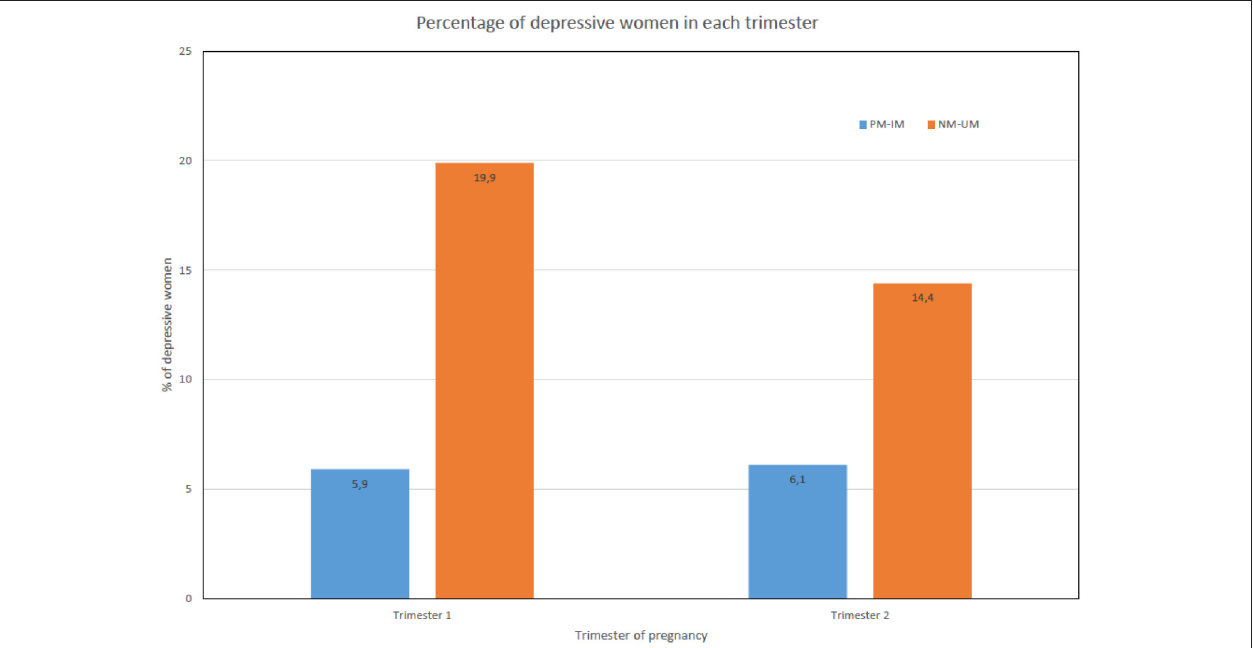
FIGURE 2 | Proportion of women with depressive symptoms during pregnancy. UM, Ultrarapid metabolizers; NM, normal metabolizers; IM, intermediate metabolizers; PM, poor metabolizers.